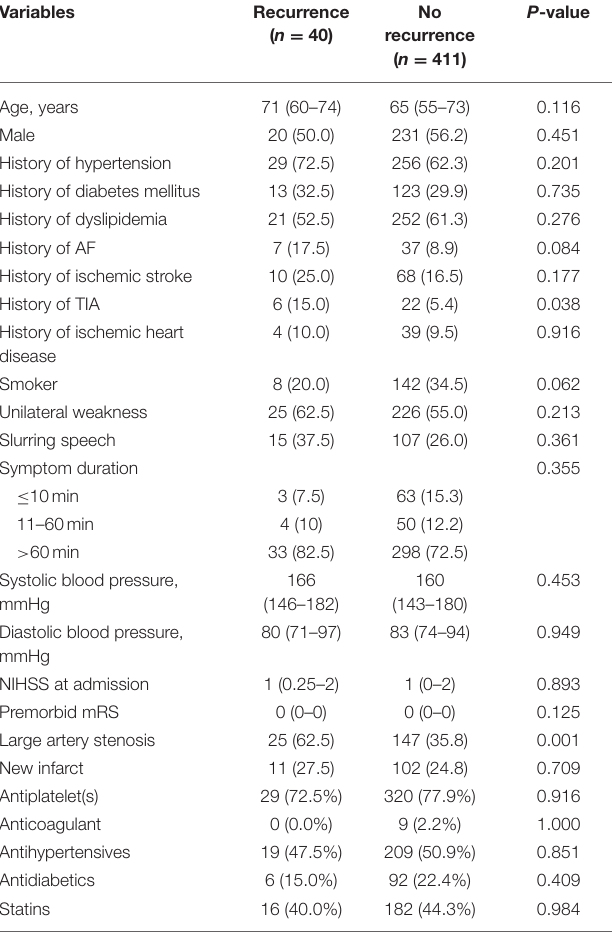
and parameter C equaling to 1 was optimal among all the others. The median sensitivity, specificity and accuracy of